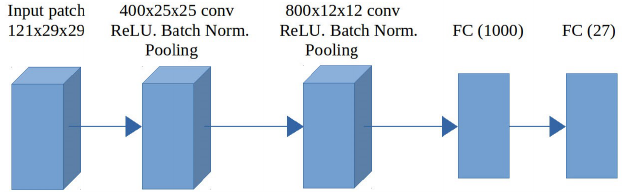
Figure 4. The architecture of the CNN model for the classification of Dataset